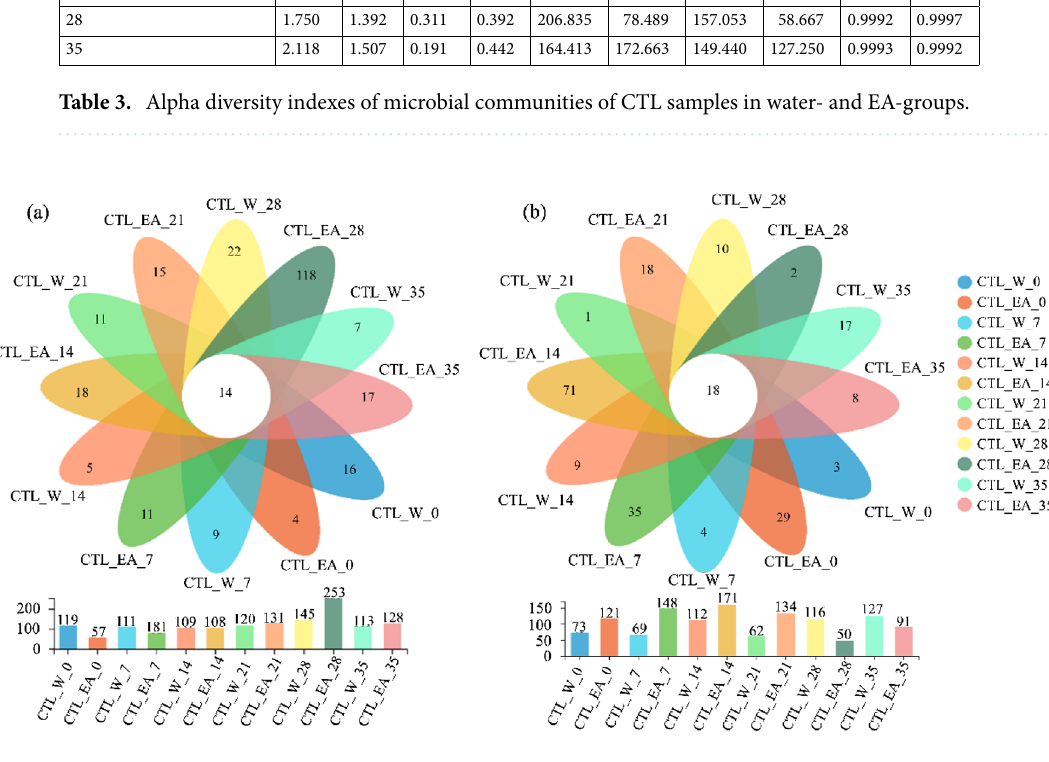
Figure 4. Venn diagram of OTU distribution of bacterial ( a ) and fungal ( b ) communities in different CTL